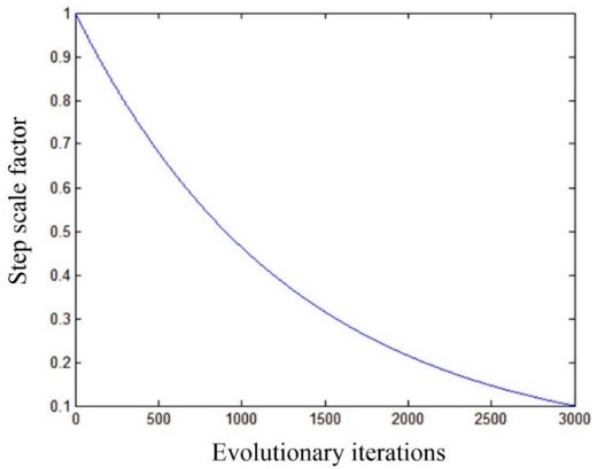
Figure 3. α 0 (30 dimensions) in the evolution of ICS algorithm.